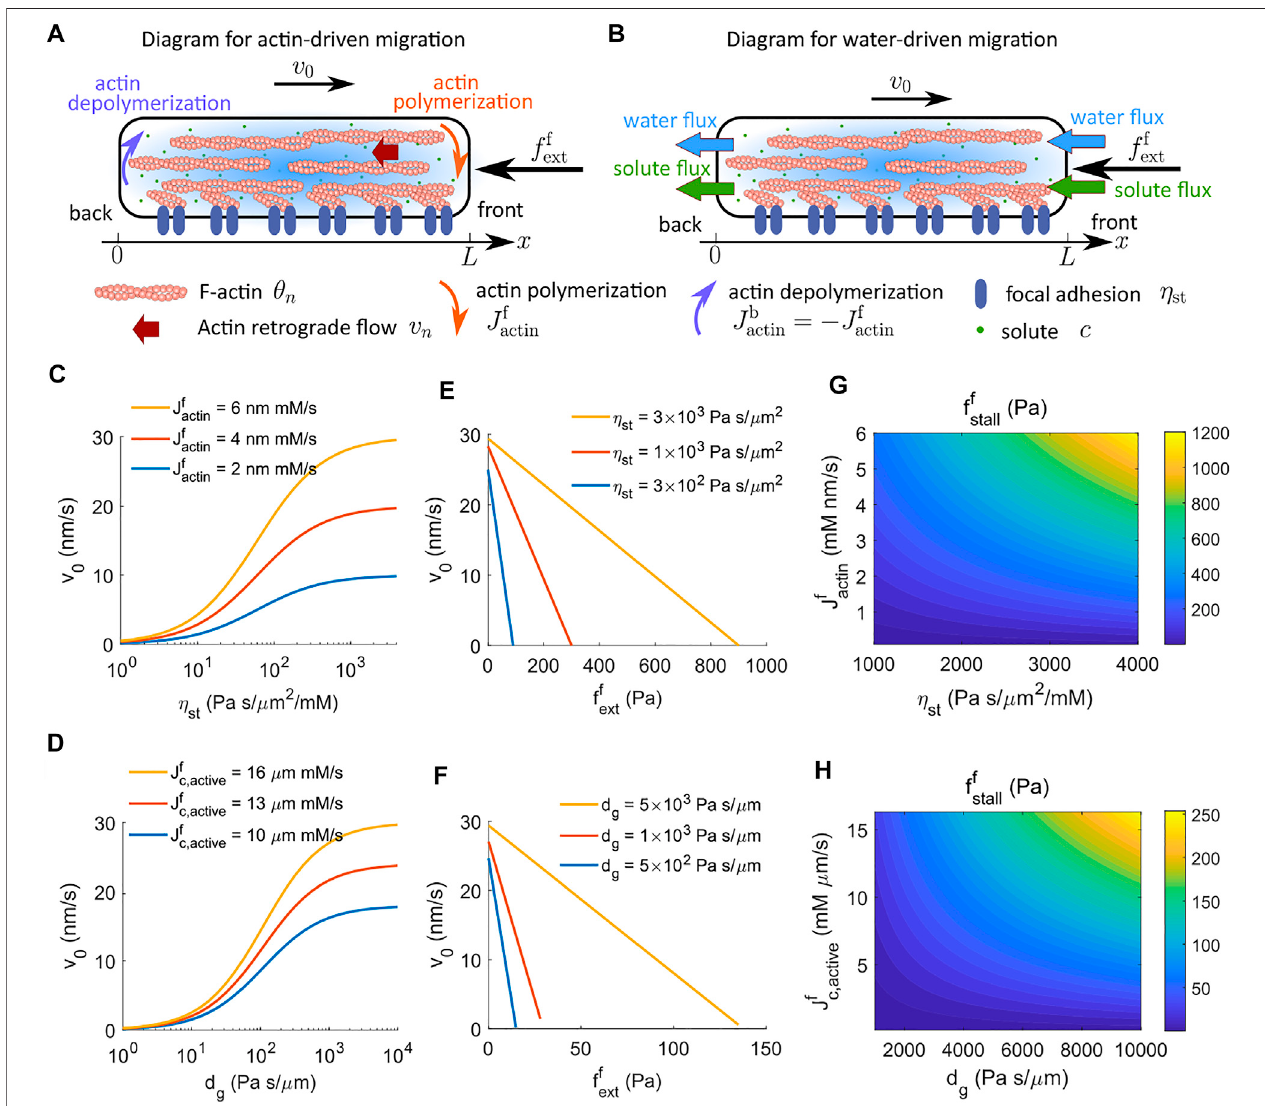
FIGURE 1 | Cell velocity and effective force generation under actin-driven and water-driven cell migration in the absence of G-actin. (A) Schematics ofactin-driven cell migration where actin polymerization and depolymerization happen at the front and back ends of the cell, respectively. G-actin is not explicitly modeled. (B) Schematicsofwater-drivencellmigration. (C) Modelpredictionofthevelocityofactin-drivencellmigrationasafunctionofthestrengthoffocaladhesion, η st ,fordifferent rates of actin polymerization at the front end of the cell. (D) Model prediction of the velocity of water-driven cell migration as a function of the coef fi cient of external hydraulic resistance, d g , for different rates of actin polymerization at the front end of the cell. (E) Predicted actin-driven cell velocity as a function of the external force for differentstrengthsoffocaladhesion. (F) Predictedwater-drivencellvelocityasafunctionoftheexternalforcefordifferentcoef fi cientsofexternalhydraulicresistance. (G) Thecontourofthestallforceperunitareaforactin-drivencellmigrationasafunctionoftherateofactinpolymerizationandthestrengthoffocaladhesion. (H) Thecontour of the stall force per unit area for water-driven cell migration as a function of the active solute fl ux and the coef fi cient of external hydraulic resistance.